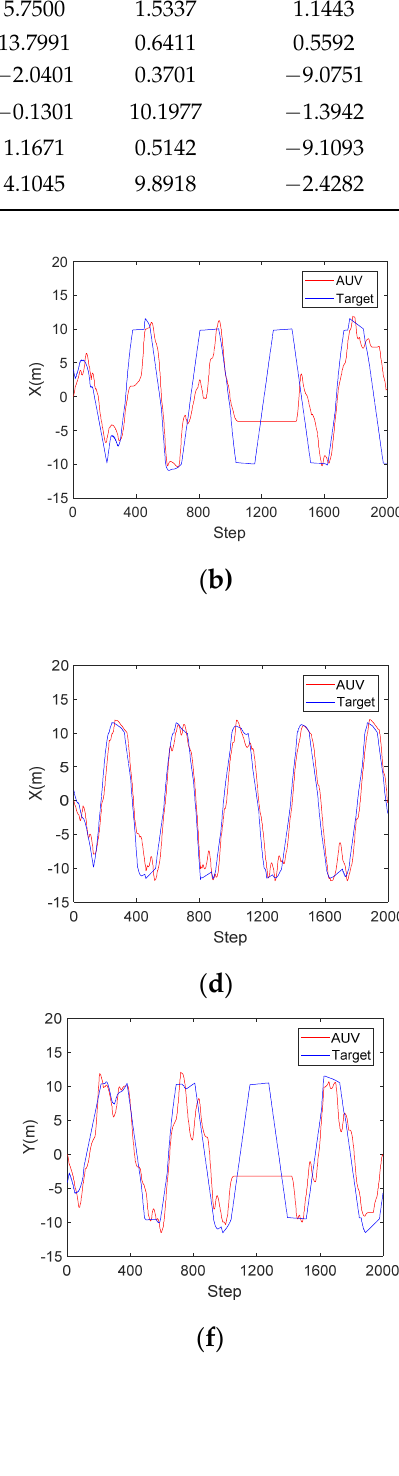
( h ) Figure 6. The coordinate change curves in Scene 1 during the process of AUV tracking the target using PPO, SAC, GAIL, and MAG, respectively: ( a – d ) the X-coordinate change; ( e – h ) the Y-coordi- nate change. In Figure 7a,e, there is a big distance error between the AUV and the target using PPO during 1300–1400 steps only. Compared with the trajectory of the AUV and the target in Figure 6a,e, the tracking accuracy of the PPO controller is less affected by noise. Figure 7b,f shows that the AUV loses the target for more time in Scene 2 than in Scene 1, indicat- ing that the tracking ability of the SAC controller deteriorated due to the noise. From the Figure 7c,d,g,h, it can be seen that the distance is smaller using PPO than GAIL during the whole tracking process. This shows that in Scene 2, both the GAIL and MAG controllers have better tracking accuracy, but compared with GAIL, the MAG controller can bring the AUV closer to the target. This indicates that the MAG controller has the best anti- interference.